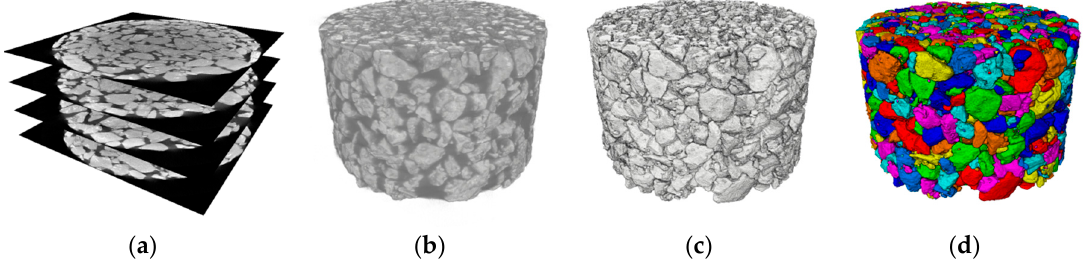
Figure 10. 3D reconstruction of aggregate structure: ( a ) CT slices; ( b ) volume rendering; ( c ) binary image after thresholding; and ( d ) connected-component detection. Table 2. Gradation of the mixture.